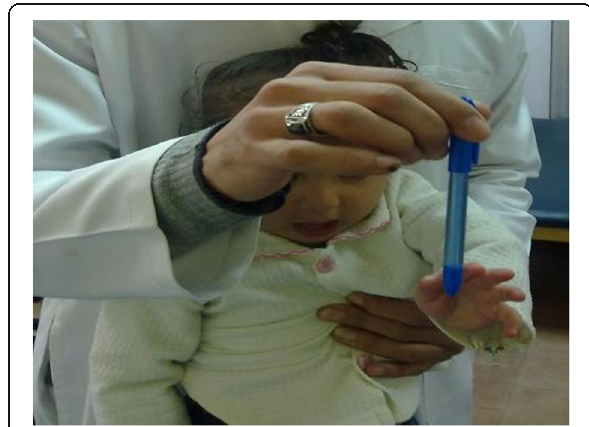
Fig. 3 Application of the active movement scale for the anterior deltoid muscle